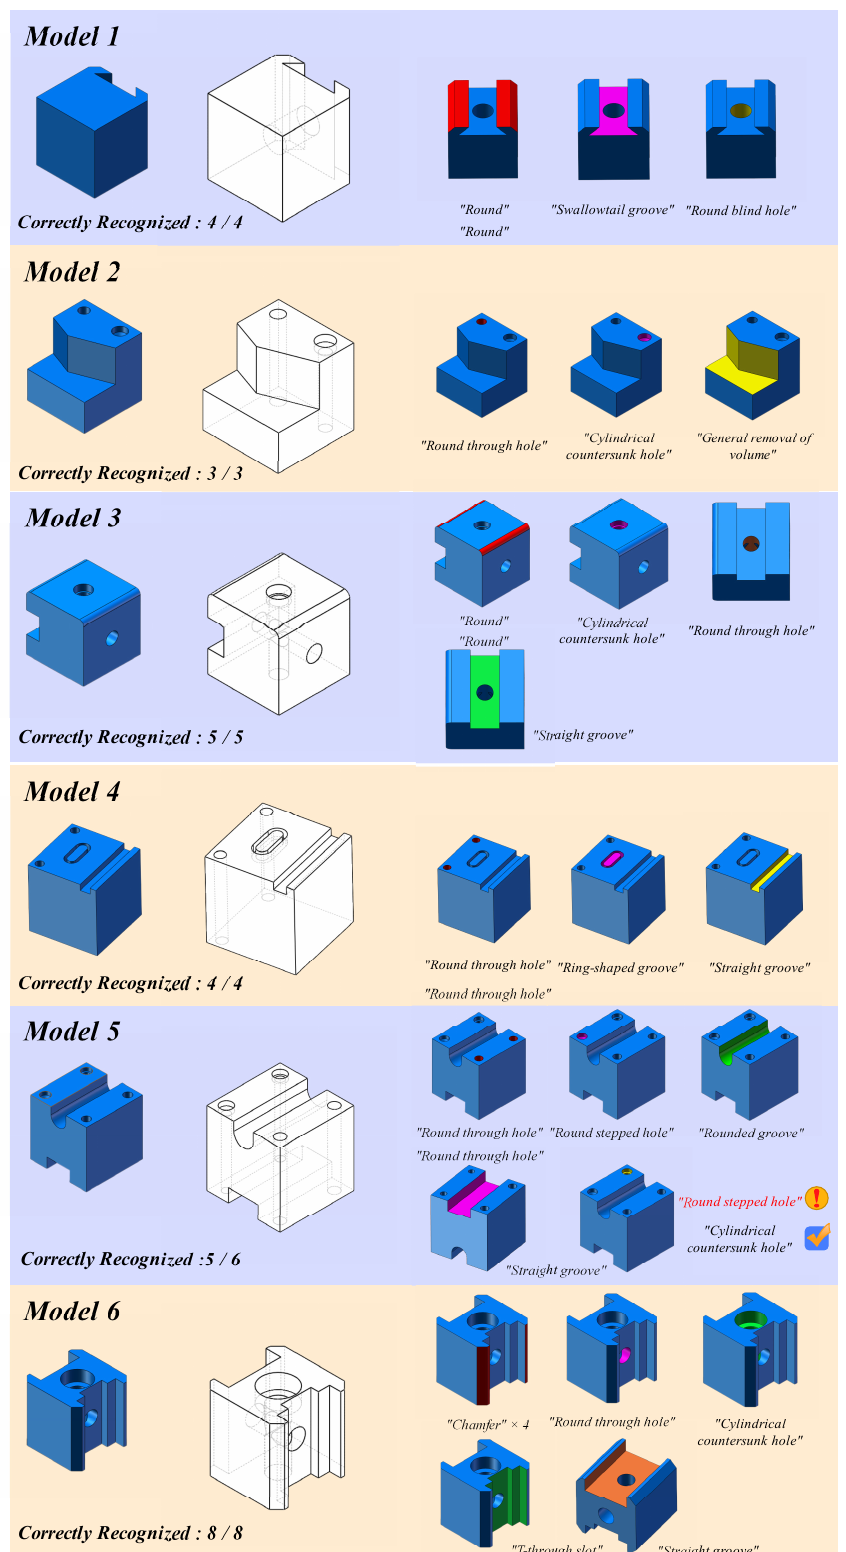
Figure 9. Multi-machining feature recognition results on several 3D CAD models. Each model contains a 3D model entity, a 3D perspective view, and the segmentation results. For every model, the correctly recognized result equals the true feature types divided by the segment-identified